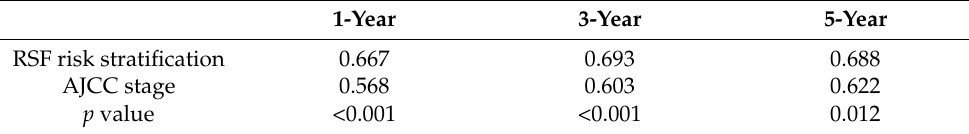
Table 5. The area under the curve of RSF risk stratification vs. AJCC Stage.